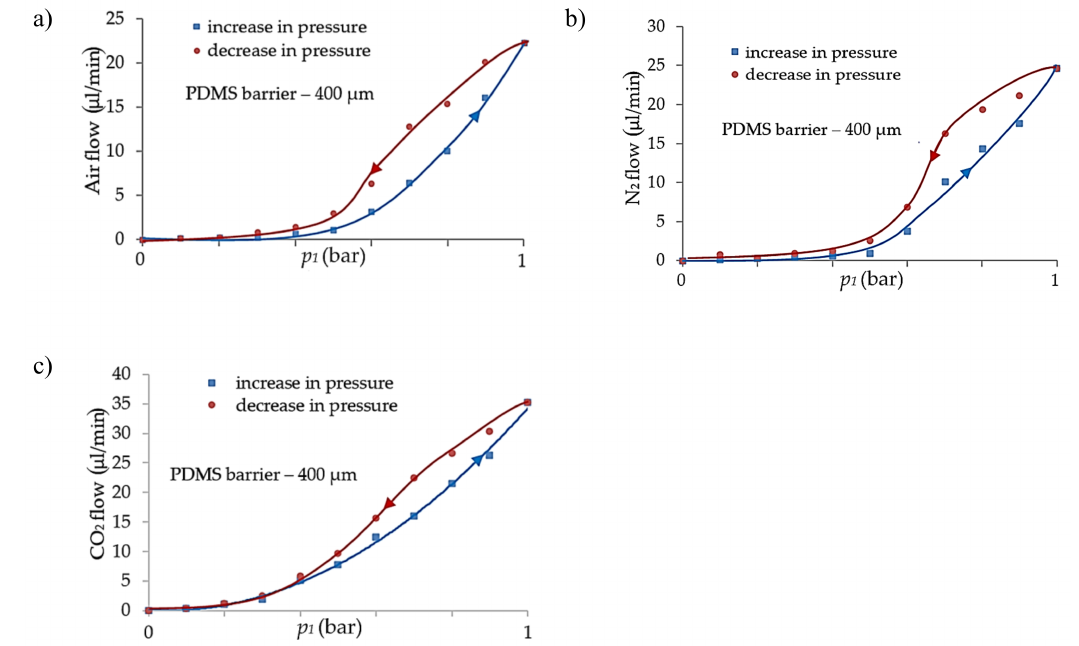
Figure 6. Pneumatic hysteresis of the regulator with a 400 µ m thick PDMS membrane: ( a ) air flow; ( b ) N 2 flow; ( c ) CO 2